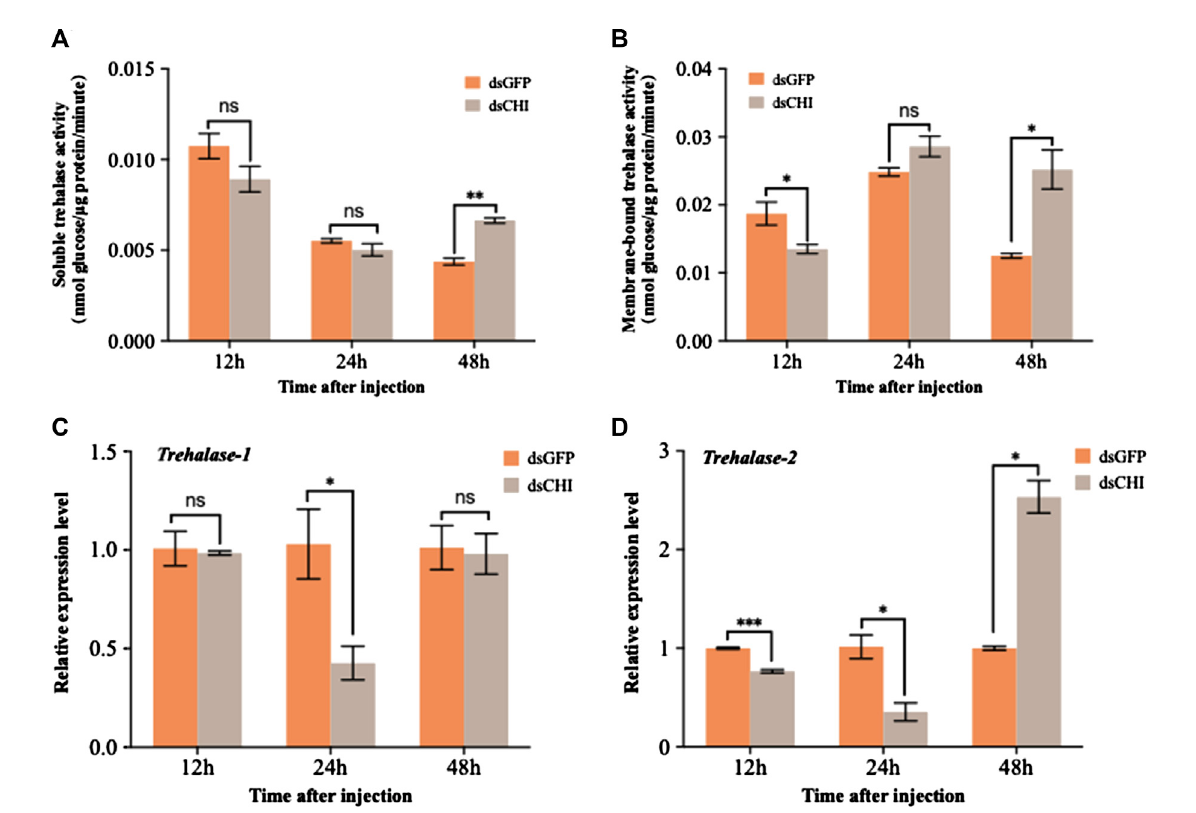
Changes in the activities of two trehalases and trehalase expression after RNAi. Spodoptera frugiperda larvae at the fi rst day of the third instar stage were divided into three groups and injected with dsGFP and dsCHI, respectively. Insects were collected and used to determine soluble trehalase activity (A) , membrane-bound trehalase activity (B) , the relative expression level of trehalase-1 gene (C) and the relative expression level of trehalase-2 gene (D) at 12, 24 and 48 h after dsRNA injection. Three replicates were performed per group. (Mean ± SE; t - test; *** p <